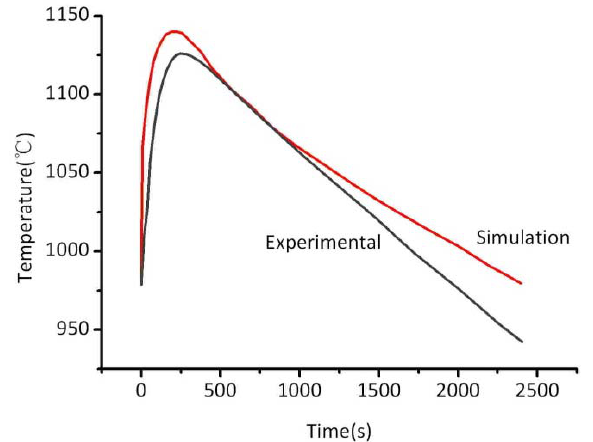
Figure 5. Comparison of the prediction and experimental cooling curve.